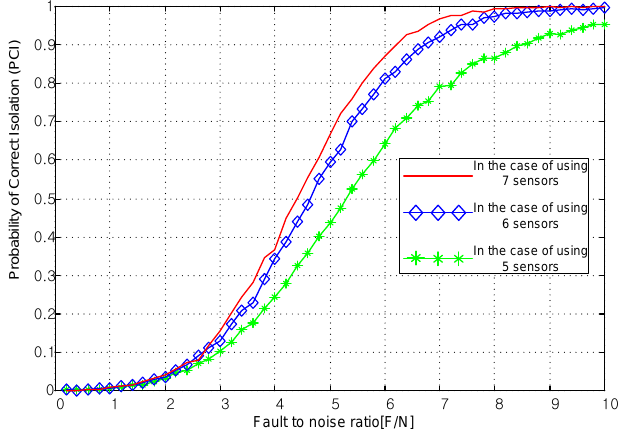
Figure 2. PCI with respect to the number of sensors and fault